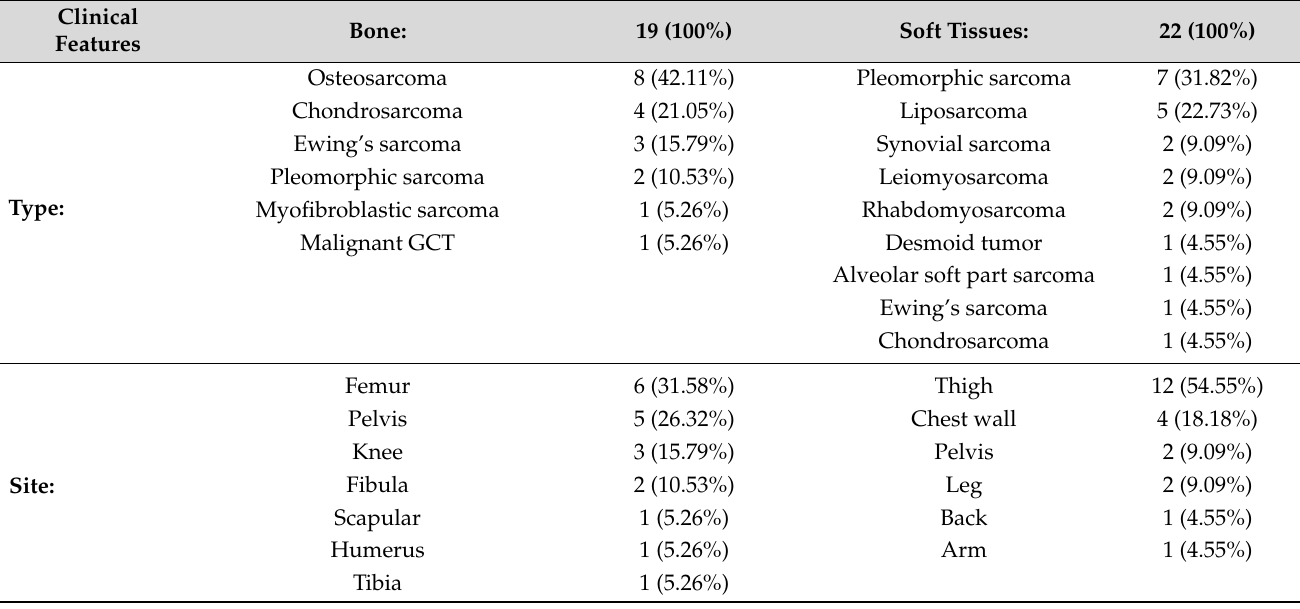
Table 2. Clinical characteristic of sarcoma